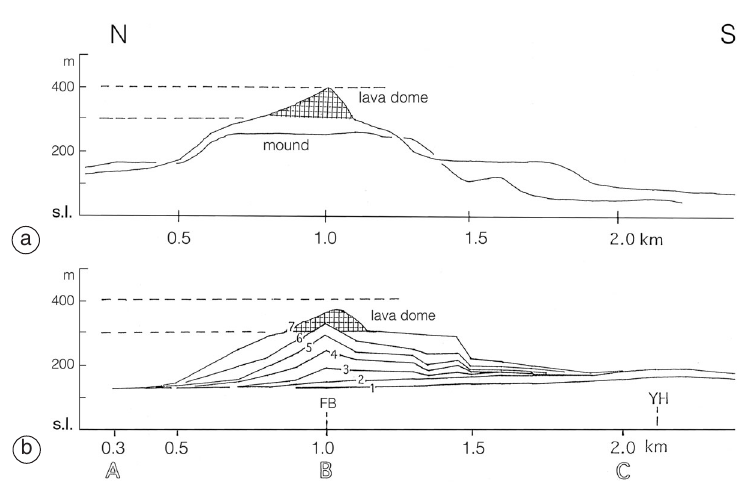
Fig. 9a,b. Comparison of pseudo growth curves and actual topographic profiles. a) Topographic profiles of the 1944 dome passing lava dome and mound; b) successive profiles of the pseudo growth curves. In fact, dome con- tinued to grow five months more.